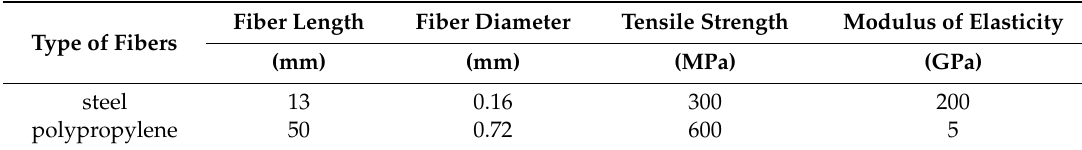
Figure 1. Type of fibers used in conducted studies: ( a ) steel fibers and ( b ) polypropylene fibers. Table 1. Properties of the fibers applied.